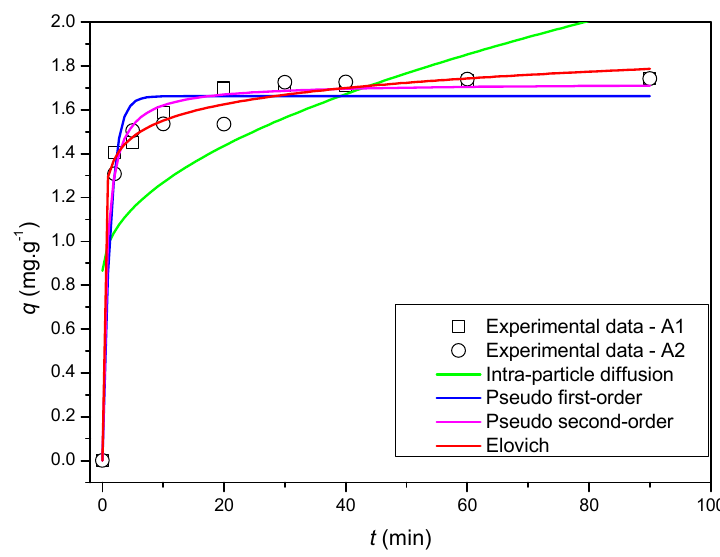
Figure 7. Kinetic models fitted to experimental data for ASC.